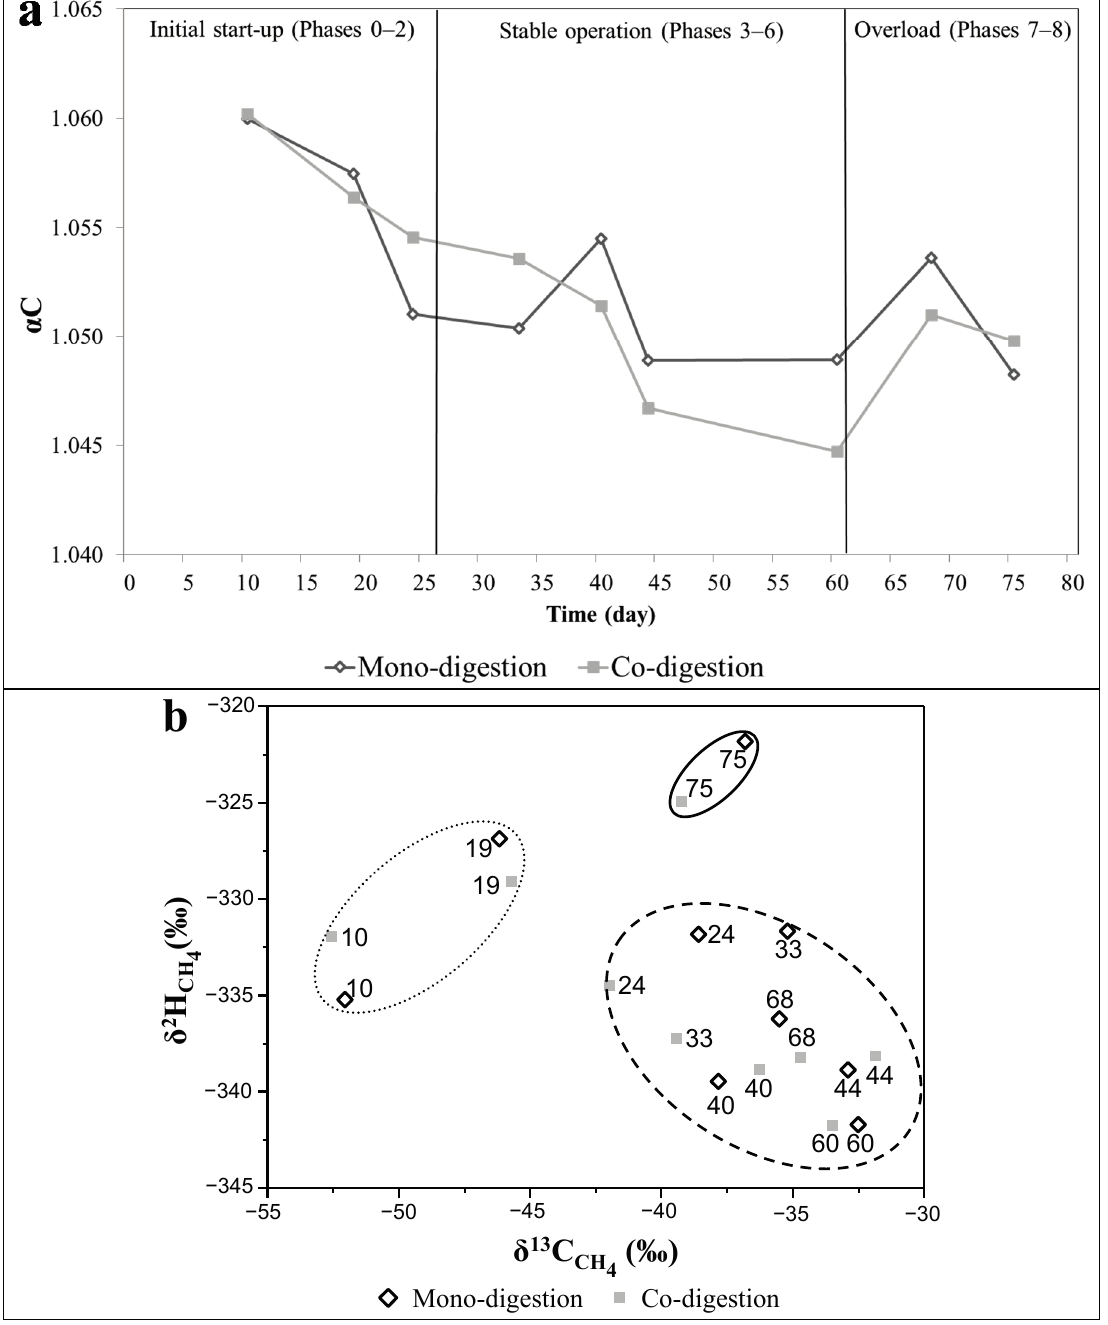
Figure 3. Characterization of the potential predominant methanogenic pathway along gradual OLR increase in biogas reactors fed with sugarcane waste products in mono- and co-digestion. In diagram ( a ) the dynamic shift of α C values are shown, while diagram ( b ) presents the correlation of δ 2 H CH4 and δ 13 C CH4 ; In ( b ) the dotted, dashed and lined hulls represent the beginning, middle, and end of the experiment, respectively. The numbers in the graphic indicate the experiment